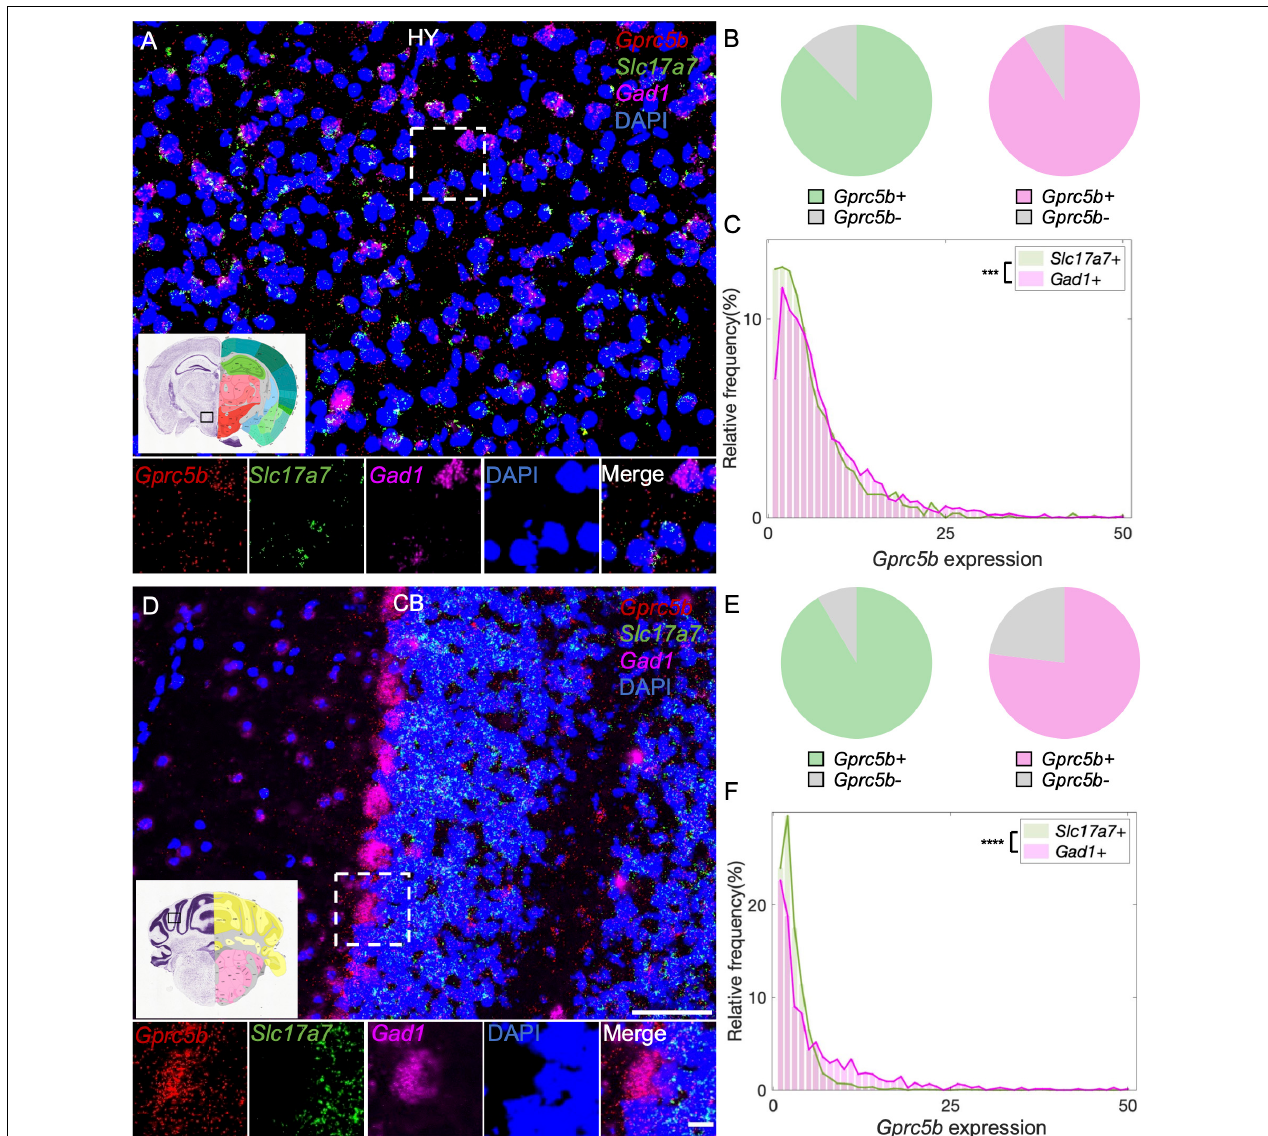
FIGURE 9 | Distribution of Gprc5b transcripts in glutamatergic and GABAergic neurons across HY and CB. Representative fluorescent images showing Gprc5b mRNA distribution in HY (A) and in CB (D) . Gprc5b was indicated in red, Slc17a7 as a marker for glutamatergic neurons in green, gad1 as a marker for GABAergic neurons in magenta, and DAPI for nuclei in blue. Pie charts demonstrating percentage of Gprc5b positive neurons in HY (B) and CB (E) where Gprc5b positive glutamatergic neurons are in green while Gprc5b positive GABAergic neurons are in magenta. (C) Frequency distribution analysis indicating Gprc5b mRNA expression in HY within glutamatergic and GABAergic neurons (Bin width = 1, sampled from 943 glutamatergic neurons and 2428 GABAergic neurons of 2–4 animals, p < 0.001 from two-sided Wilcoxon–Rank sum test). (F) Frequency distribution analysis of Gprc5b mRNA expression in CB in glutamatergic and GABAergic neuronal populations (Bin width = 1, sampled from 2888 glutamatergic neurons and 755 GABAergic neurons from 2 to 4 animals, p < 0.0001 from two-sided Wilcoxon–Rank sum test). Scale bar: 50 µ m; scale bar of magnified images: 10 µ m; reference brain images were obtained from Allen brain atlas. *** p < 0.001; **** p <